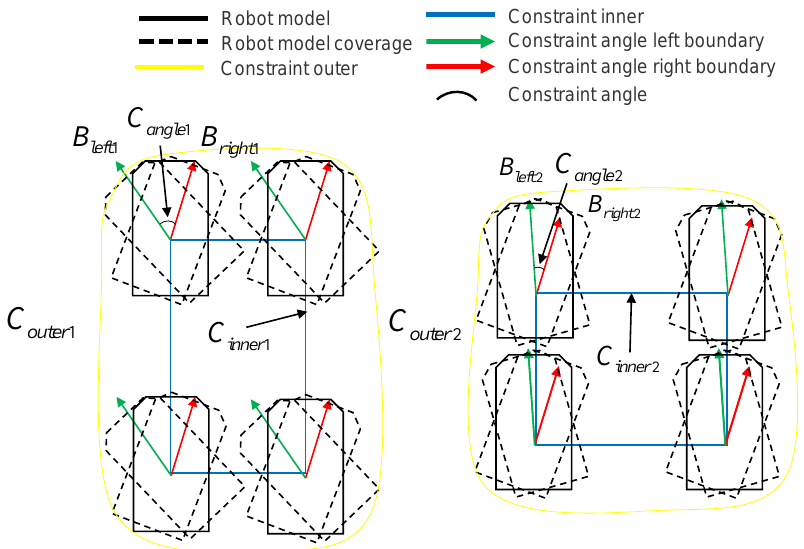
Figure 6. Offline pre-computed spatial security envelope set: Figure left and right show two examples of security envelopes, respectively. Among them, C angle is the angle constraint, B left , B right is the boundary of the angle constraint, C inner is the inner constraint, C outer is an external constraint. Different combinations of inner and angle constraints resulted in different outer